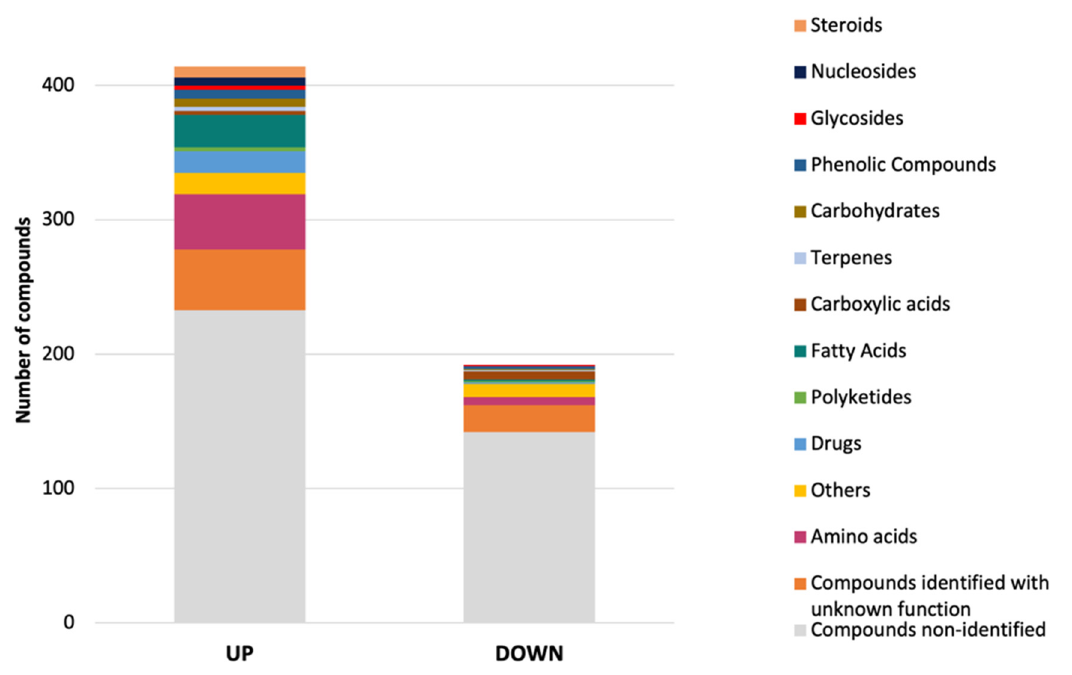
Figure 5. Structural classification of up and down regulated ( p < 0.01) metabolites produced by Emericellopsis cladophorae MUM 19.33, grown in the presence of sea salts.